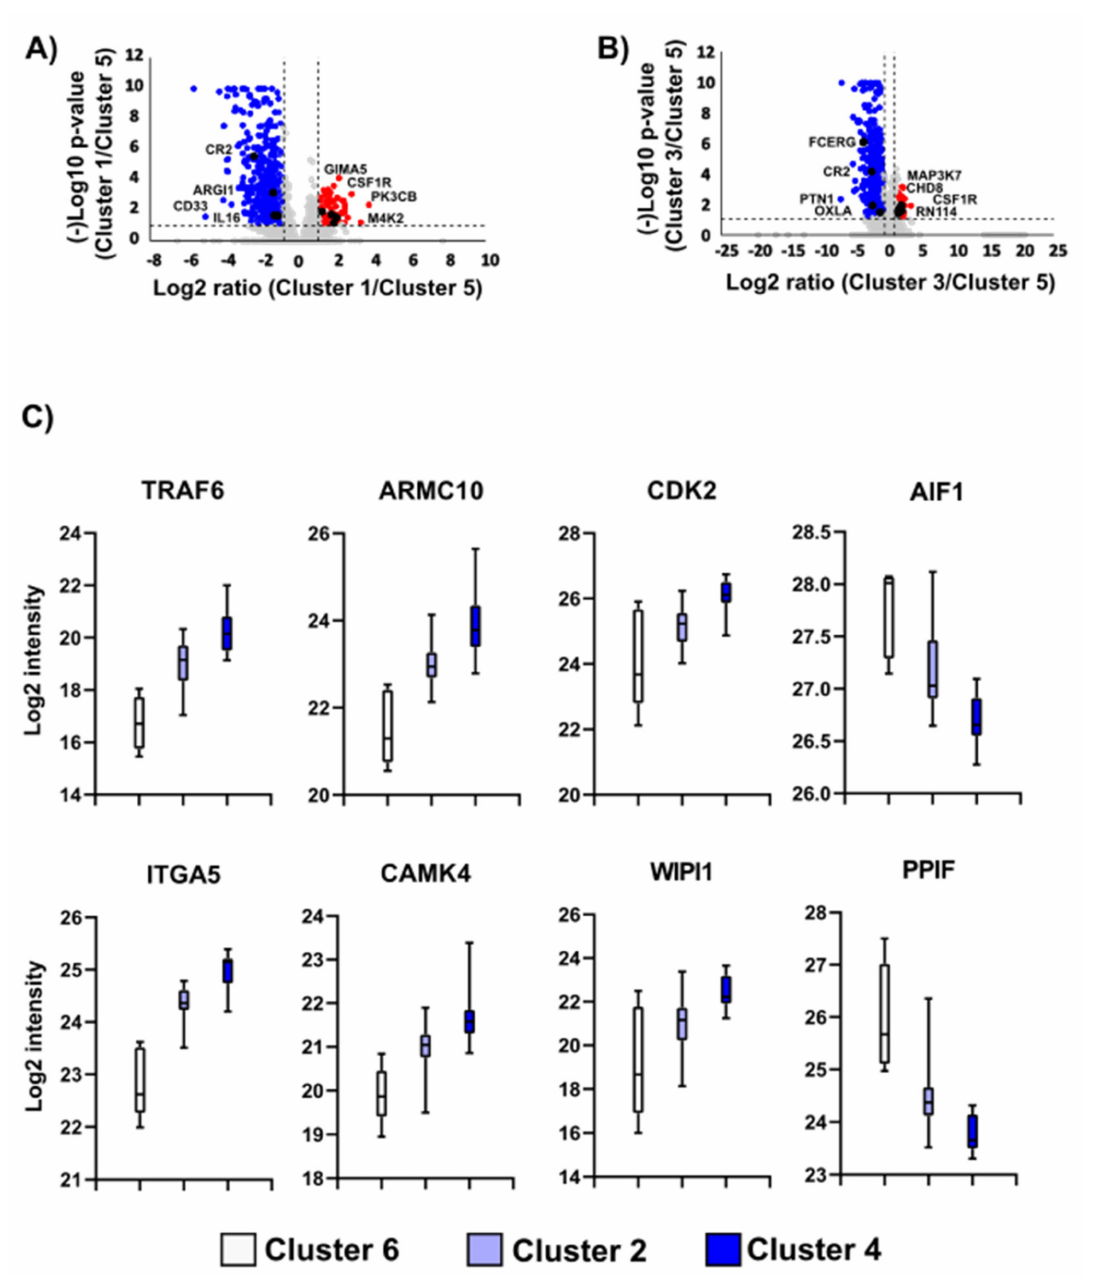
Figure 4. The main up- and downregulated proteins in the sample clusters. ( A ) Volcano plot of sample cluster comparison (between sample cluster 5 and sample cluster 1) with diverse overall survival. ( B ) Volcano plot of sample cluster comparison (between sample cluster 5 and sample cluster 3) with different progression-free survival. ( C ) Examples of the differential expression of the proteins between sample cluster 6, 4 and 2 with different disease-free